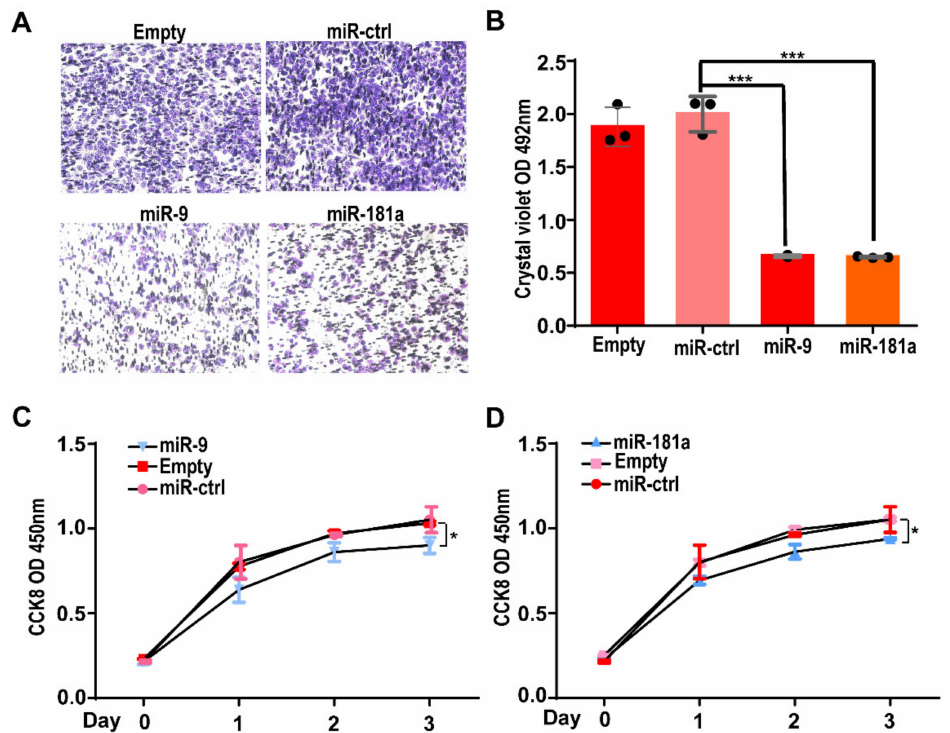
Figure 4. Effects of two miRNAs on the migration and proliferation of HepG2 cells. ( A ) Representative image of migrated HepG2 cells transfected with the hsa-miR-9 or hsa-miR-181a mimic in a Transwell assay. ( B ) The number of migrated cells was determined by measuring the OD value after crystal violet staining. The results are presented as the means ± SDs. Statistical comparisons of values were made using Student’s t -test. *** p < 0.001. ( C , D ) The growth curve of HepG2 cells, as assessed by a CCK-8 assay after transfection with miRNA mimic of the hsa-miR-9 ( C ) or hsa-miR-181a mimic ( D ) for 96 h. The results are presented as the means ± SDs. Statistical comparisons of values were made via one-way ANOVA. * p <